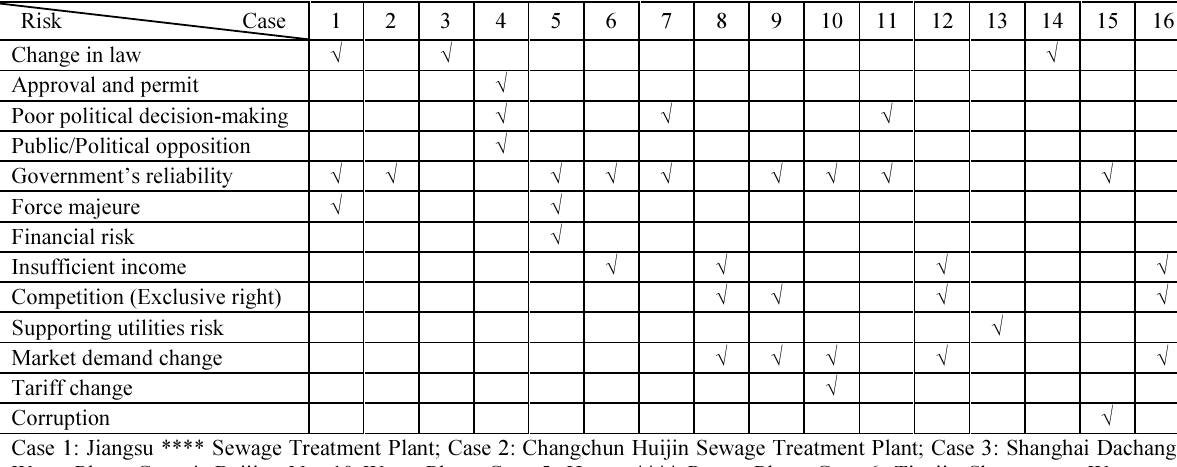
Table 1. Principal risks encountered in past PPP projects of China Risk